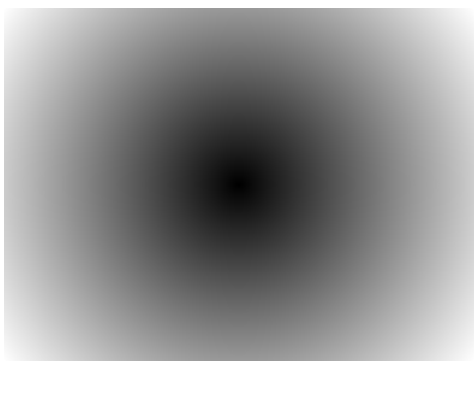
Figure 5. Image pattern used for vignetting